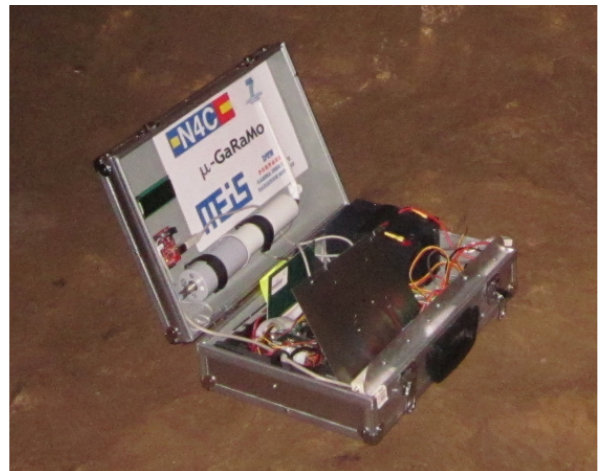
Fig. 6. View of mobile DTN node mounted on a train. Figure 6. View of mobile DTN node mounted on a train 3